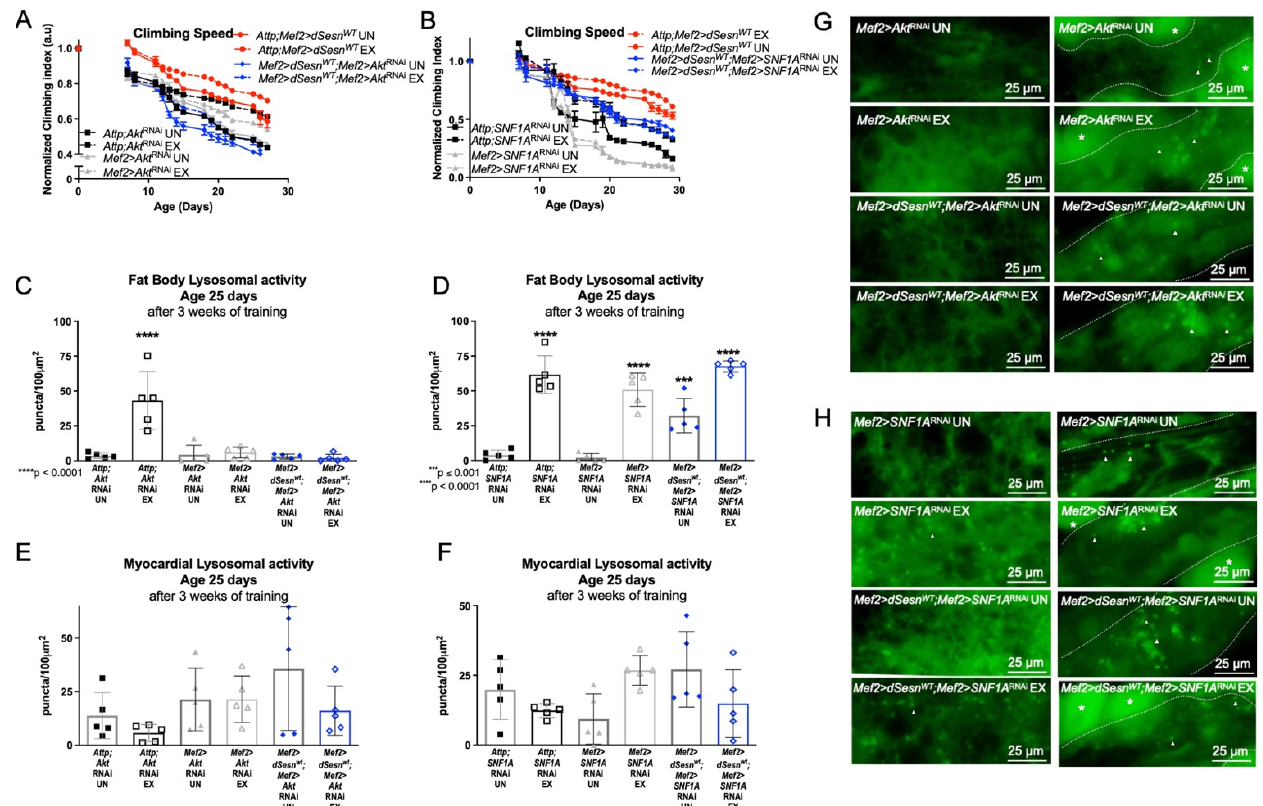
Figure 4. AKT is required for Sestrin and exercise to improve climbing speed and enhance lysosomal activity. ( A ) Flies overexpressing dSesn in muscles ( Attp;Mef2 > dSesn WT ) climb faster than controls and climb as fast as exercised controls (2-way ANOVA, p ≤ 0.0156, p ≥ 0.1300). Exercised flies expressing RNAi against AKT in muscles ( Mef2 > Akt RNAi UN) improve climbing speed but do not reach the speed of exercised controls (2-way ANOVA, p ≤ 0.0319). dSesn expression does not